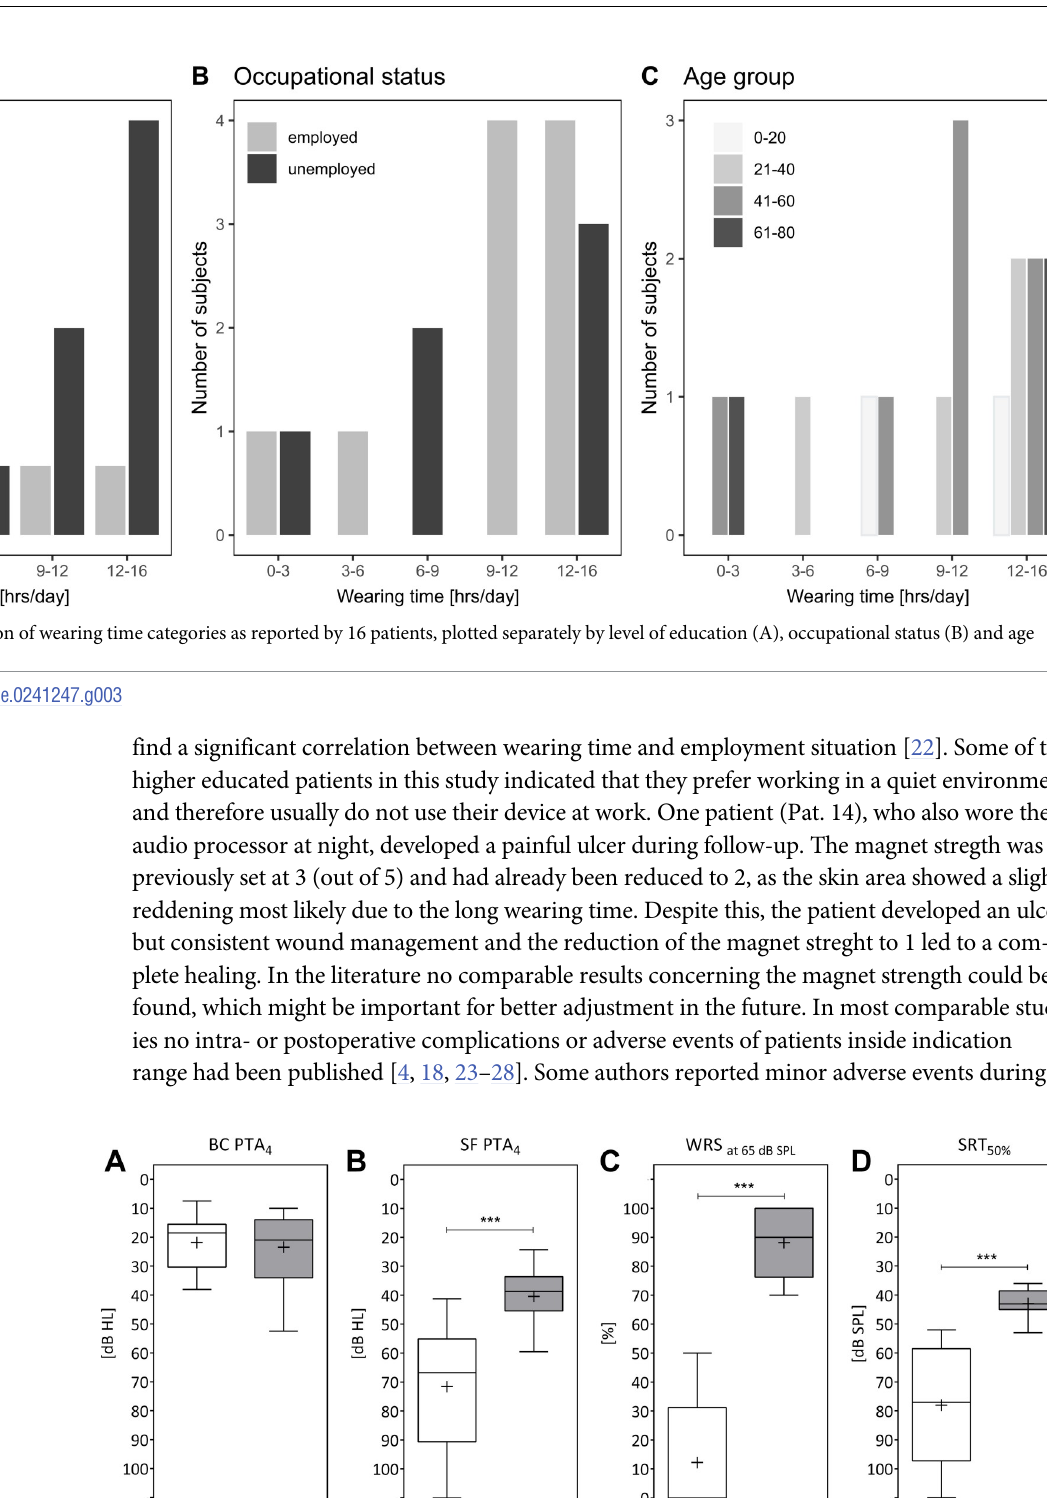
PLOS ONE | https://doi.org/10.1371/journal.pone.0241247 November2,